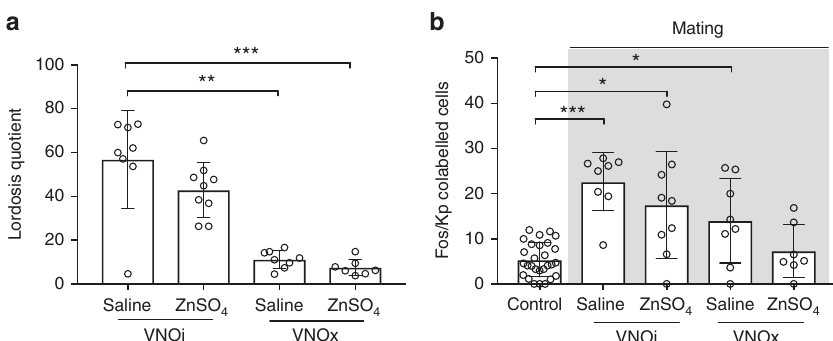
Fig. 3 Lordosis behavior depends on the accessory olfactory system in female mice. a Lordosis behavior was strongly disrupted upon VNO removal, but only slightly after ablation of the MOE by infusion with a zinc sulfate solution (ZnSO 4 ). b Mating failed to activate RP3V kisspeptin neurons when both peripheral olfactory sensory input organs (VNOx/ZnSO 4 ) were ablated. Sham procedures were performed for each intervention as controls. No signi fi cant differences between control animals were found; therefore, all controls were combined into a single group. Bars represent the mean ± SEM. * P ≤ 0.05; ** P ≤ 0.01; *** P ≤ 0.001; Dunn ’ s multiple comparison test; a n = 8/9/8/7; b n = 8/9/8/7. For all experimental details, see Supplementary Table 1